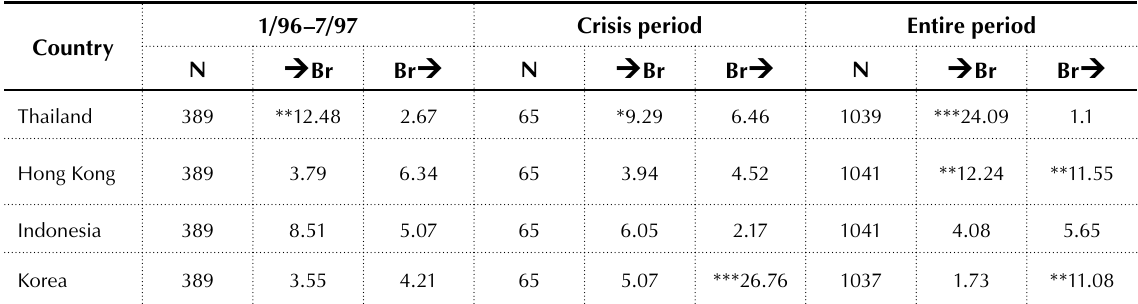
Table 5. Liquidity contagion after the Brazilian crisis Country